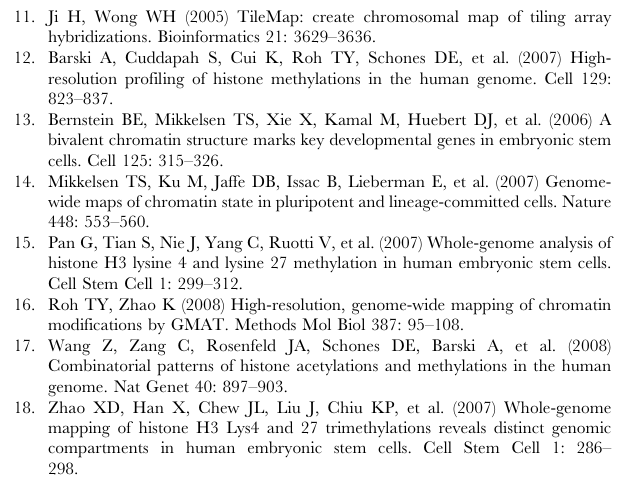
Figure S1 Distribution of H3K4me3 enrichment at JGI FilteredModels genes. Figure S2 ChIP-qPCR validation of randomly selected H3K4me3-enriched regions. (A) Average enrichment (three experiments) determined for a genomic locus on scaffold 1 (scaffold_1:6458583-6458633). Asterisk indicates enrichment less than 2.5. (B) Average enrichment relative to a genomic locus on scaffold 919 (scaffold_919:126357-126407). Error bars represent the SEM of three biological